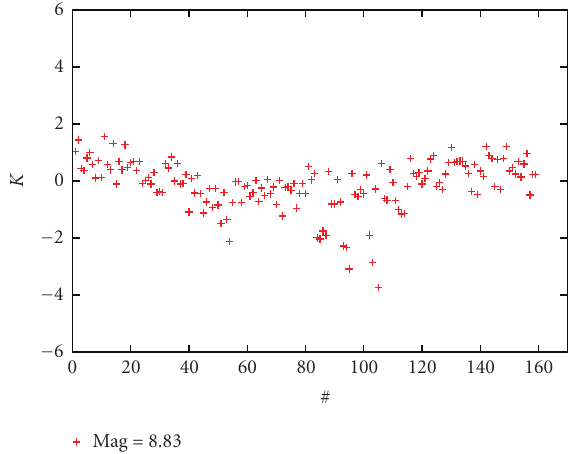
Figure 3: Bright source: uncertainty limited by the zero-point measurement.